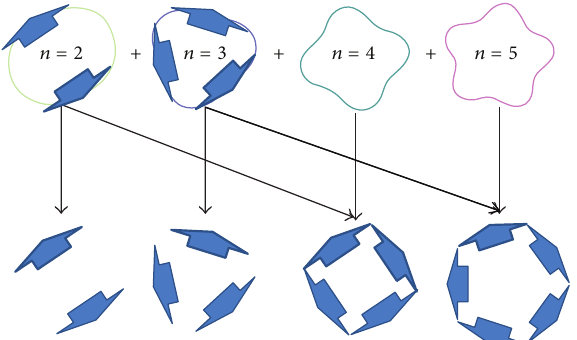
Figure 24: Primary shapes for V 𝑛 , 𝑛 = 2 –5 are shown. The thick arrows indicate the dominant directions of particle emission. The thin arrows indicate the shapes which contribute to each